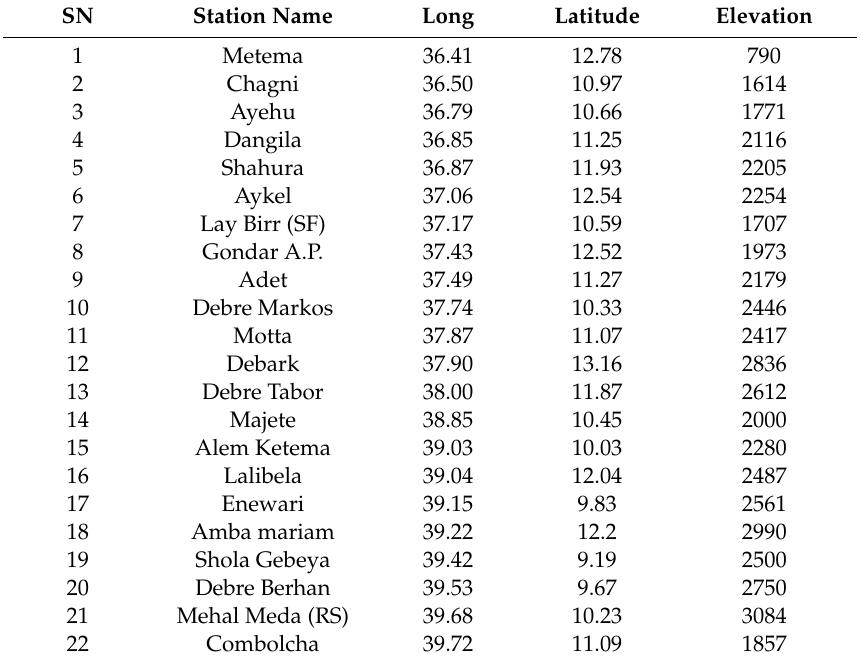
Table 1. List of meteorological stations mapped in Figure 1 with their geographic locations and elevation. Stations are sorted by longitude. Note that the station number (SN) in this table corresponds to station labels in Figure